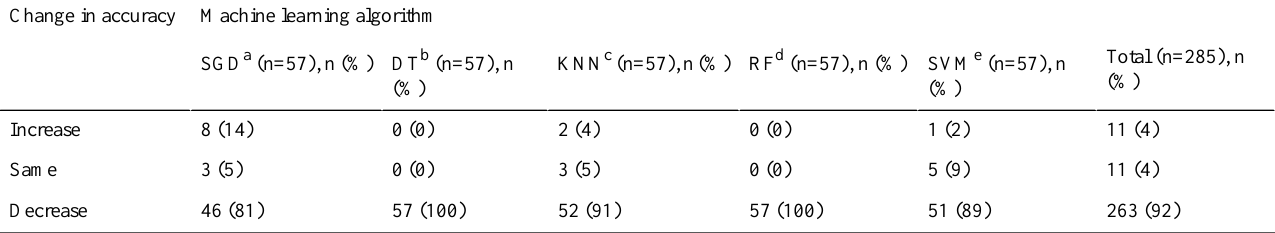
Table 3. Changes in accuracy for each machine learning model and synthetic data type (19 datasets and 3 synthetic data generators considered providing 57 synthetic datasets to